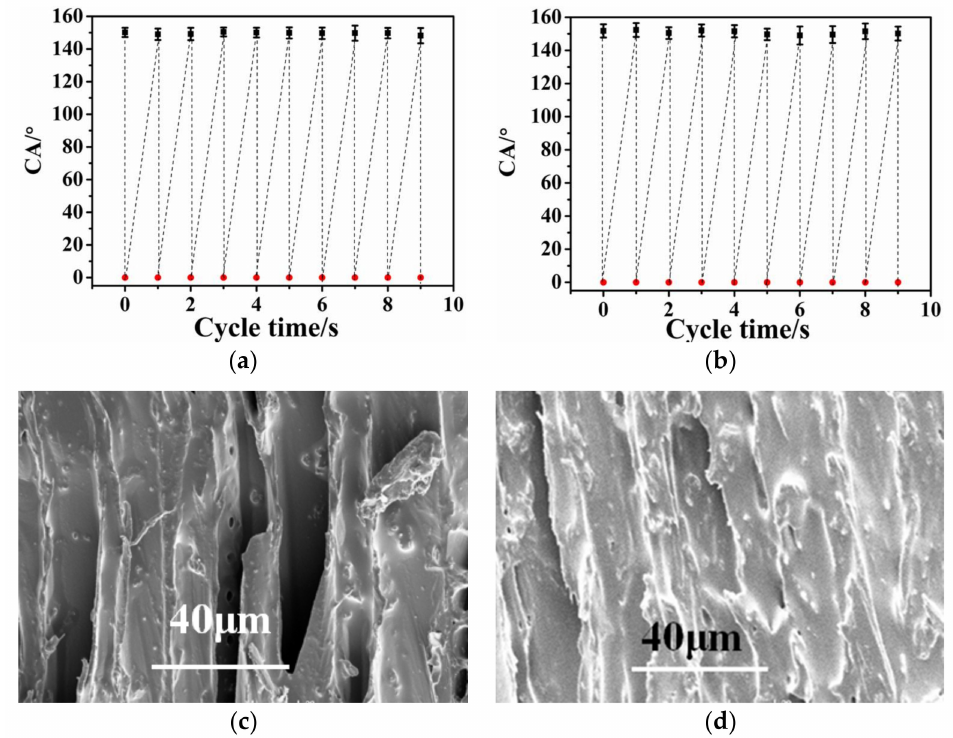
Figure 7. Self-replenishment of the superhydrophobic surface by ( a ) acid etching–healing and ( b ) alkali etching-healing tests. The SEM images of the etched wood surface after ( c ) acid etching and ( d ) alkali